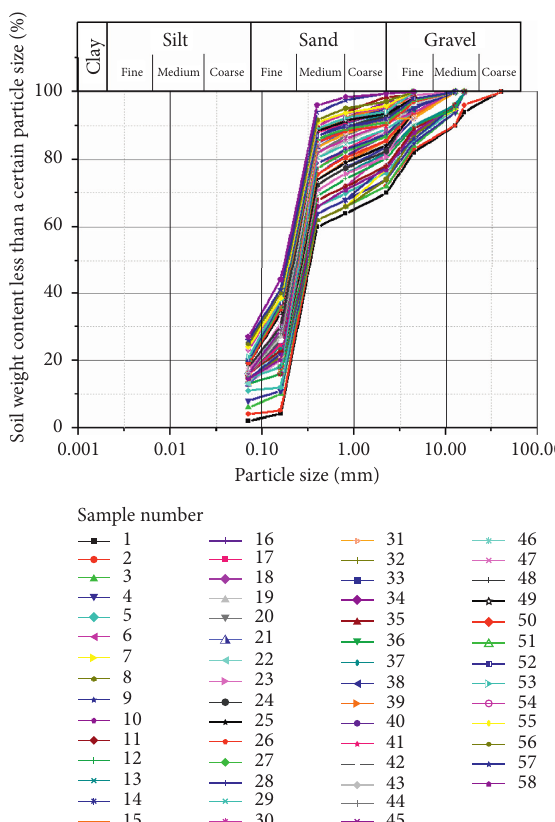
Figure 4: Particle gradation curve of the K -1 stratum.